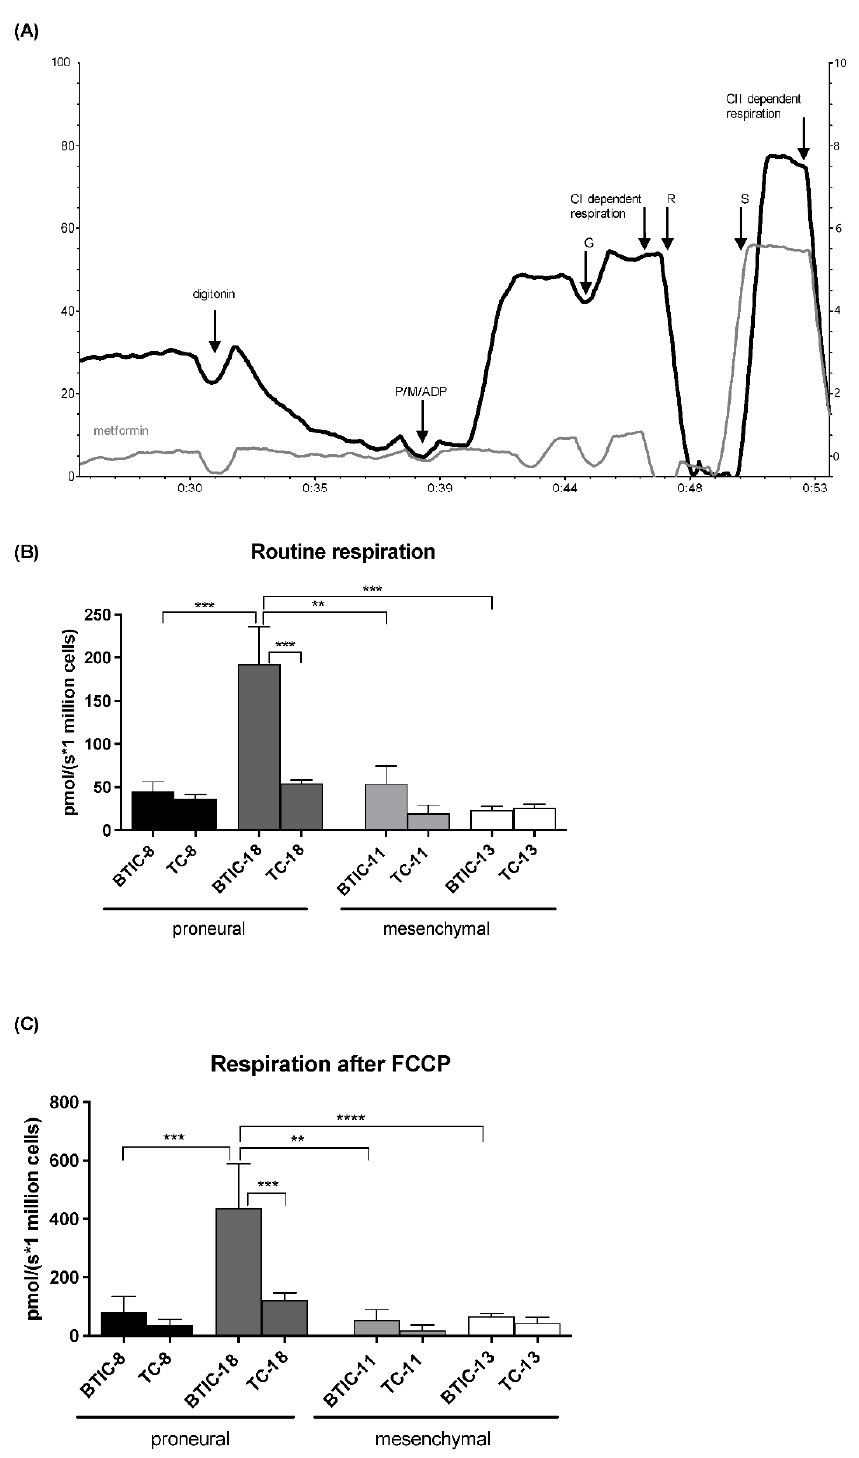
Figure 3. ( A ) Metformin (1 mM) inhibits complex-I-dependent respiration, but barely affects complex-II-dependent respiration in high-resolution respirometry. ( B ) Routine and ( C ) FCCP-stimulated respiration varied between BTIC and TC lines. P = pyruvate; M = malate; ADP = adenosine diphosphate; G = glutamate; CI = complex I; CII = complex II; R = rotenone; S = succinate; FCCP = carbonyl cyanide-p-trifluoromethoxyphenylhydrazone. All assays were performed in triplicate. Significant results are only depicted for valid comparisons, i.e., comparing proneural and mesenchymal BTICs or proneural and mesenchymal TCs, or the corresponding BTIC and TC pair. Asterisks indicate, ** p < 0.01, *** p < 0.001, **** p <